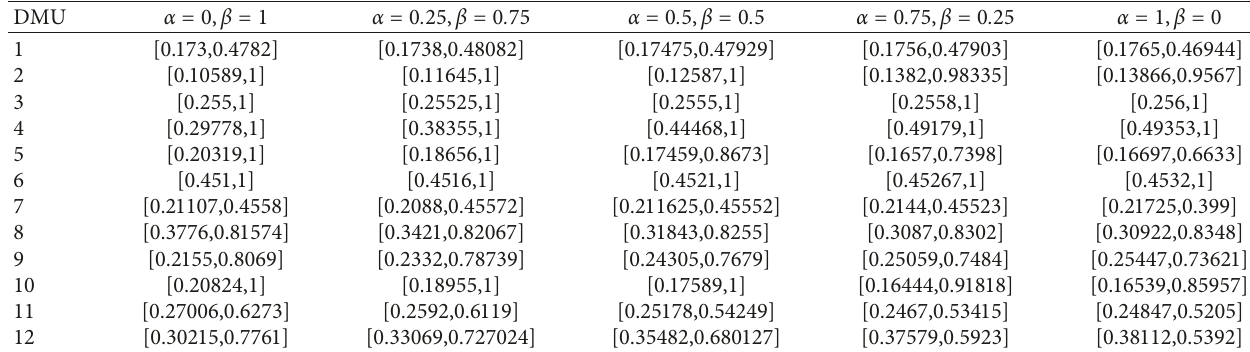
Table 5: Optimistic-pessimistic efficiency calculations of the second stage for different levels of α - β cuts. DMU